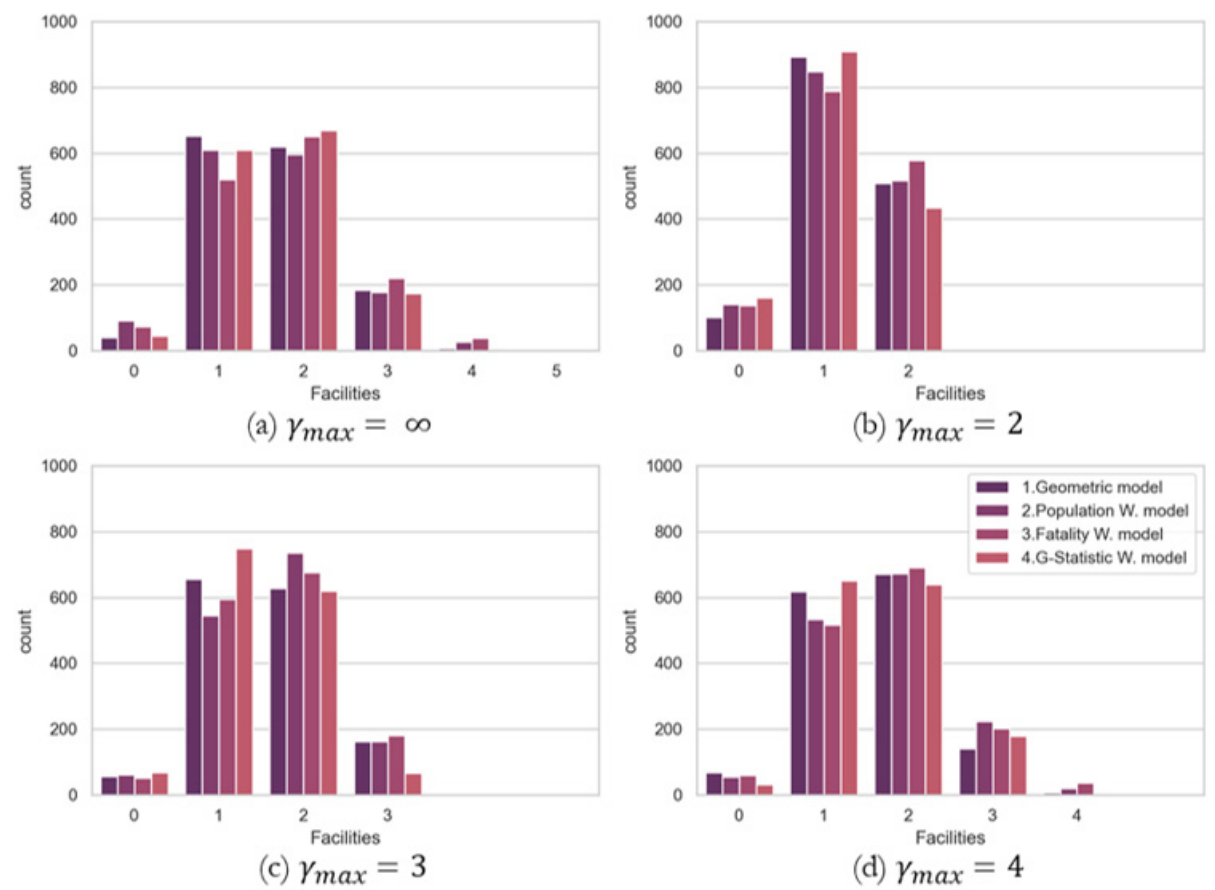
Figure 10. The number of facilities accessible from each demand location by the models and γ max for the TraCt-ESC model. ( a ) γ max = ∞ ; ( b ) γ max = 2; ( c ) γ max = 3; ( d ) γ max = 4.